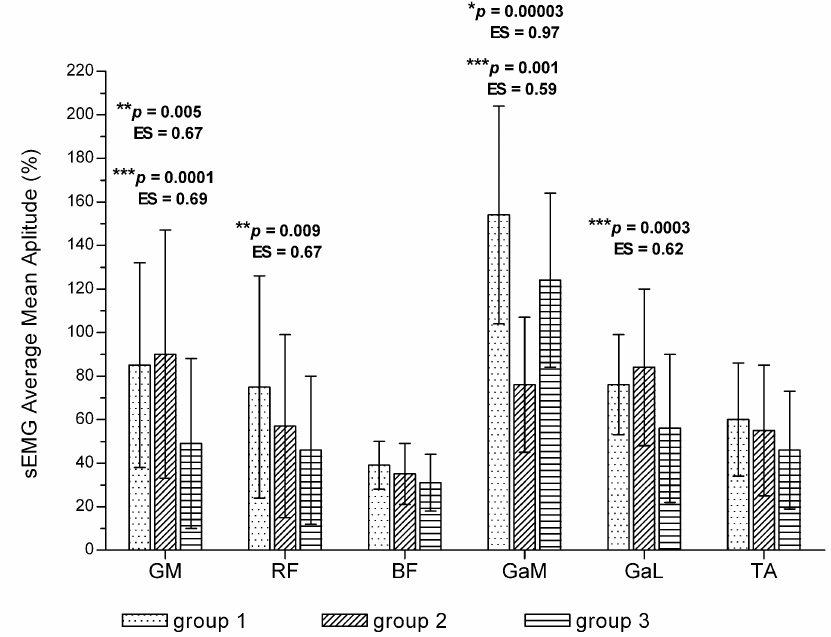
Figure 3. Differences in average mean amplitude of sEMG signal among patients with different walking time. p *— p value between study groups 1 and 2; p **— p value between study groups 1 and 3; p ***— p value between study groups 2 and 3. ES—effect size (Cohen d). Values are expressed as mean ± SD